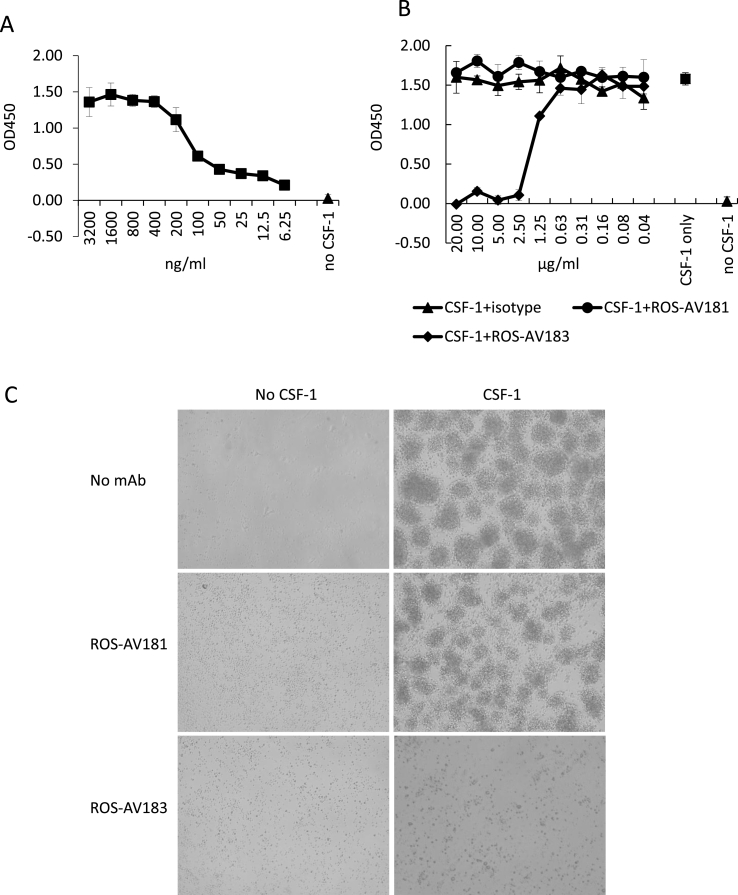
Neutralising effect of mAbs to CSF1. (A) Chicken CSF1 was titrated out on Ba/F3 cells stably transfected with CSF1R (Ba/F3-CSFR) to determine a suitable concentration for neutralising assay. 400 ng/ml was chosen. (B) Ba/F3-CSFR were cultured with CSF1, CSF1 pre-incubated with either ROS-AV181 or 183, mouse IgG1 control or without CSF1 for 72 h before performing MTT assays. Cells cultured with CSF1 or CSF1 pre-incubated with ROS-AV181 or isotype control proliferated. Cells cultured with CSF1 pre-incubated with ROS-AV183 were dead when >2.5 μg/ml of antibody was used. Assays were carried out in triplicate and representative data from three independent experiments are shown. (C) Chicken bone marrow cells were cultured with CSF1 pre-incubated with mAbs, CSF1 only or without CSF1. Original magnification objective lens 10X.